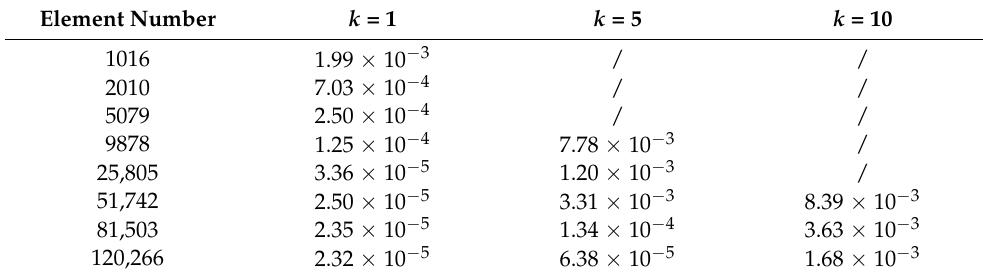
Table 4. Numerical errors (L 2 ) obtained by the FEM + PML (COMSOL) with respect to the increasing element number and